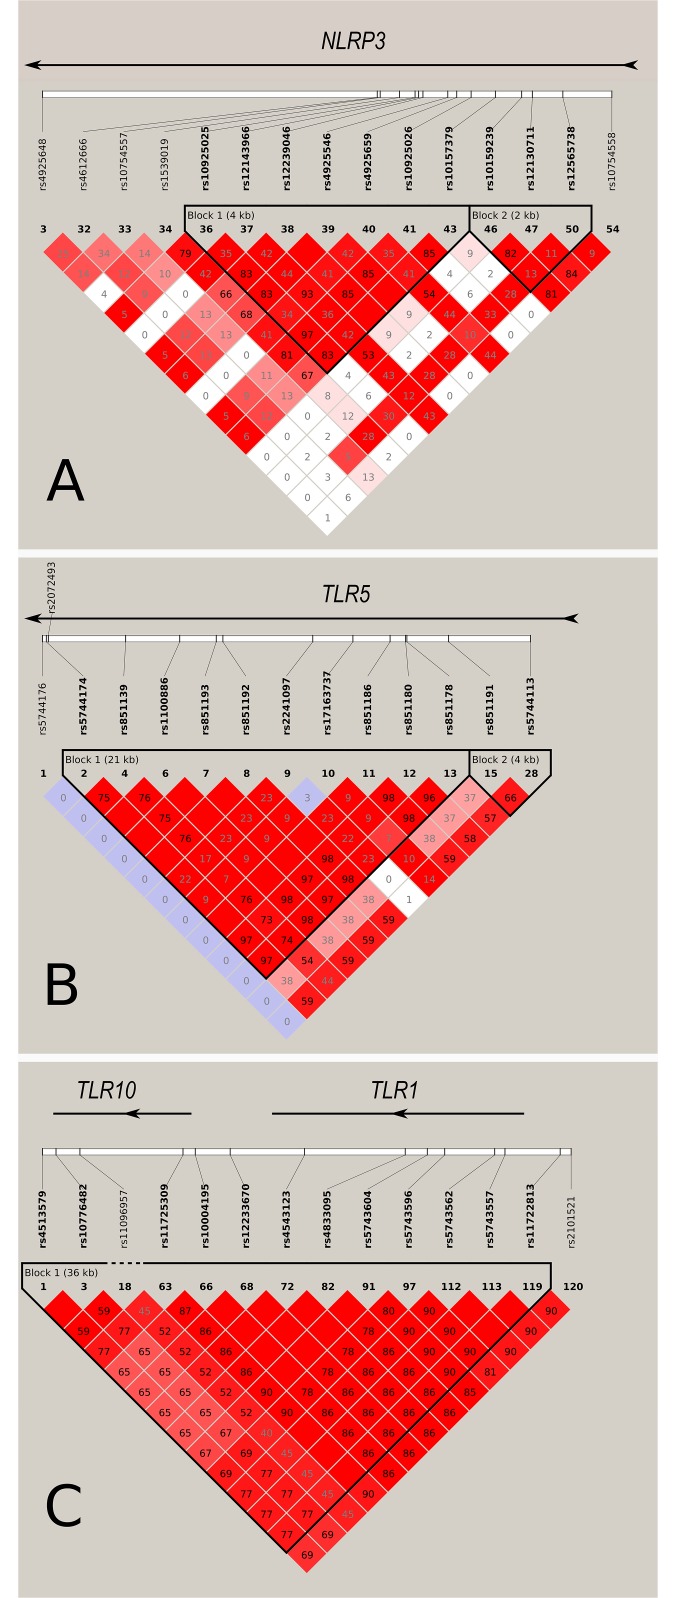
Linkage disequilibrium-maps for A) NLRP3, B) TLR5, and C) TLR10/1.Numbers in squares represent r2. Darker red indicates stronger linkage disequilibrium. Maps were made using Haploview software version 4.2 and CEPH/CEU HapMap dataset (Phase II+III merged, release 28/ August10). HapMap data were downloaded by respective genes (TLR5 and NLRP3) and for TLR10/1 data spanning both genes. To simplify LD-maps, SNPs were selected in the following way: NLRP3: minor allele frequency (MAF) >0.1, Hardy-Weinberg equilibrium (HW) p-value >0.01, genotype>50%, force include: rs10754558, force exclude #4–29; TLR5: MAF >0.1, HW p-value >0.01, genotype>50%, force include rs5744176, force exclude # 17–25; TLR10/1: MAF >0.1, HW p-value >0.01, genotype>50%, force include rs11096957, force exclude #4–58, 98–111.